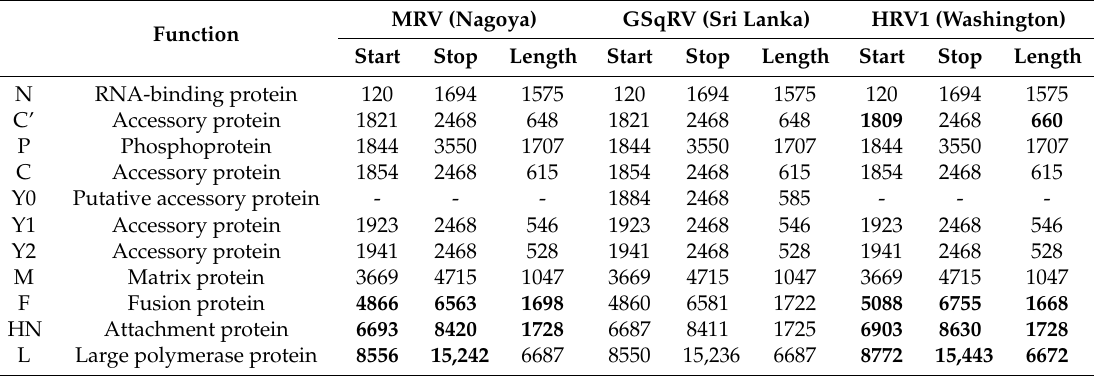
Table 1. Comparison of positions and lengths of the coding sequences of Giant squirrel